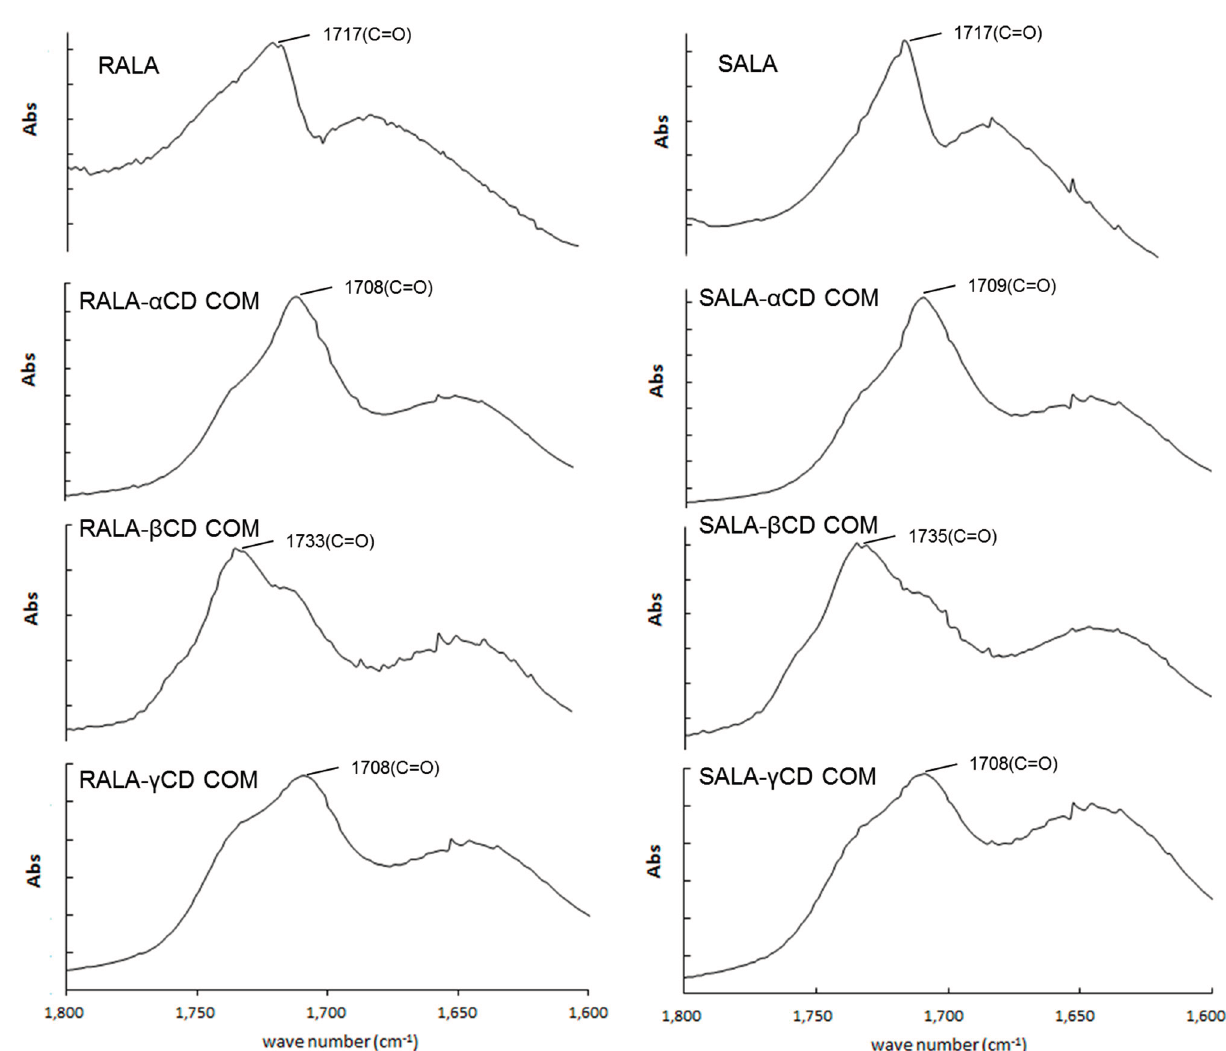
Figure 6. Enlarged micro-IR spectra of RALA-CD and SALA-CD complexes. (1600–1800 cm − 1 ) (COM: